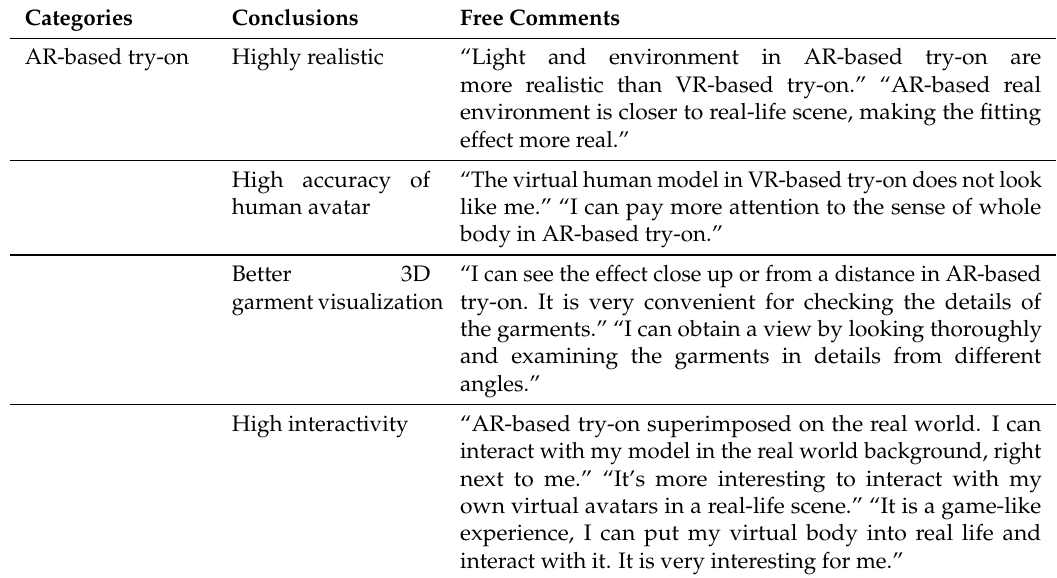
Table 3. Illustrative excerpts and main conclusions of free comments mentioning AR-based try-on.